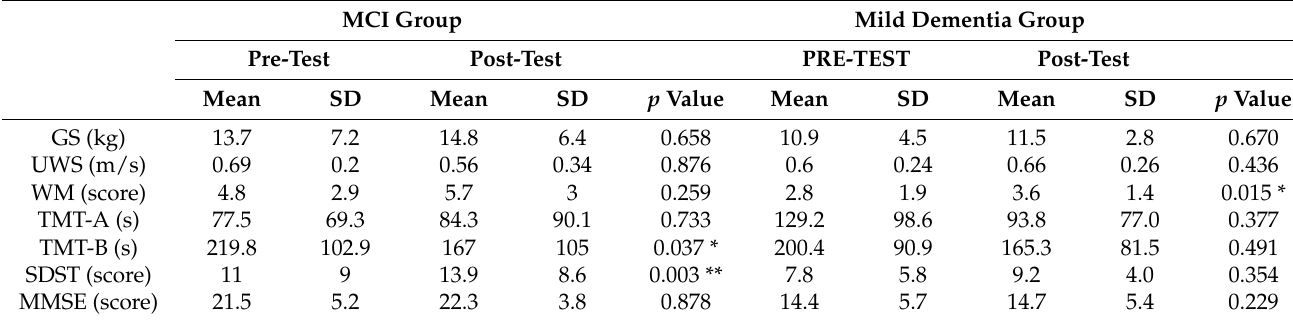
Table 3. Result of pre-test and post-test in each